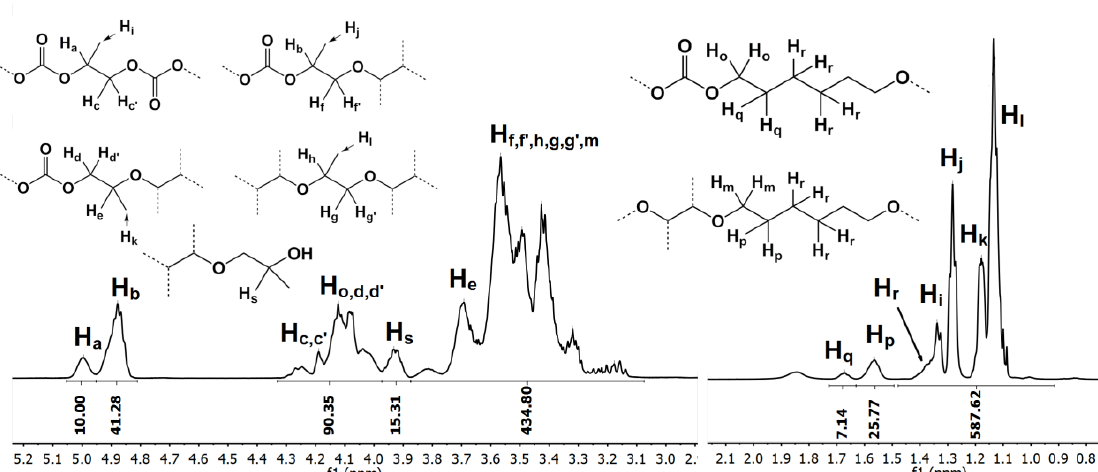
Figure 9. 1 H NMR spectrum of OECHD.